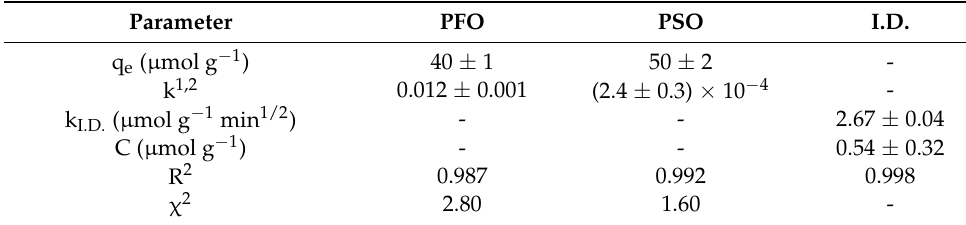
Table 1. Kinetic parameters fitted by PFO, PSO and ID models by NLR analysis.